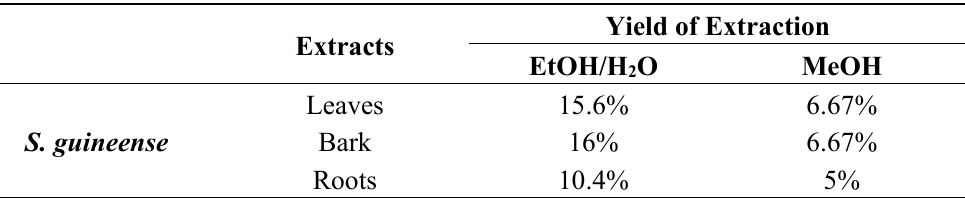
Table 1. Yield extract of S. guineense